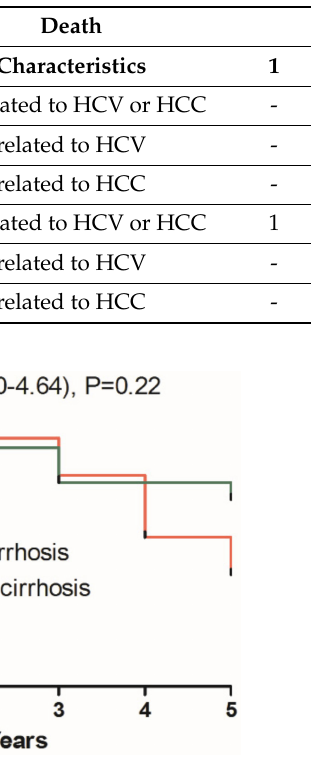
Table 3. Deaths in particular years of the follow-up and its relationship with HCV and hepatocellular carcinoma (HCC).